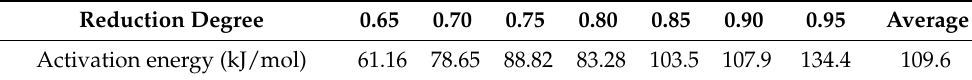
Figure 11. ln( d α / dt ) versus 1/ T at different reduction degrees. Table 3. Activation energy at different reduction